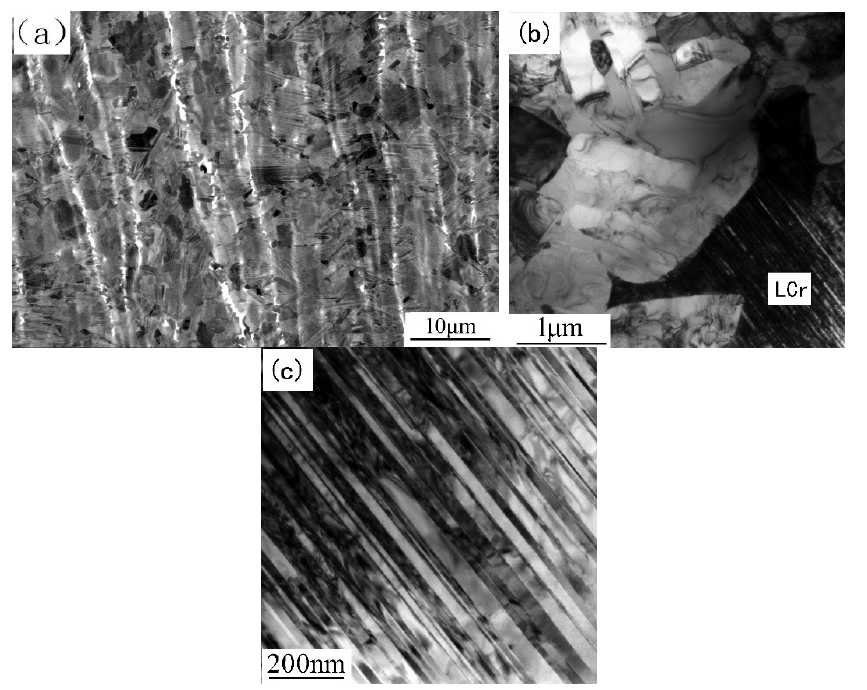
Figure 7. Microstructure of SDZ in CJ: ( a ) SEM-BSE image; ( b ) TEM image; ( c ) TEM image showing the thinner lamellar spacing of the LCr.